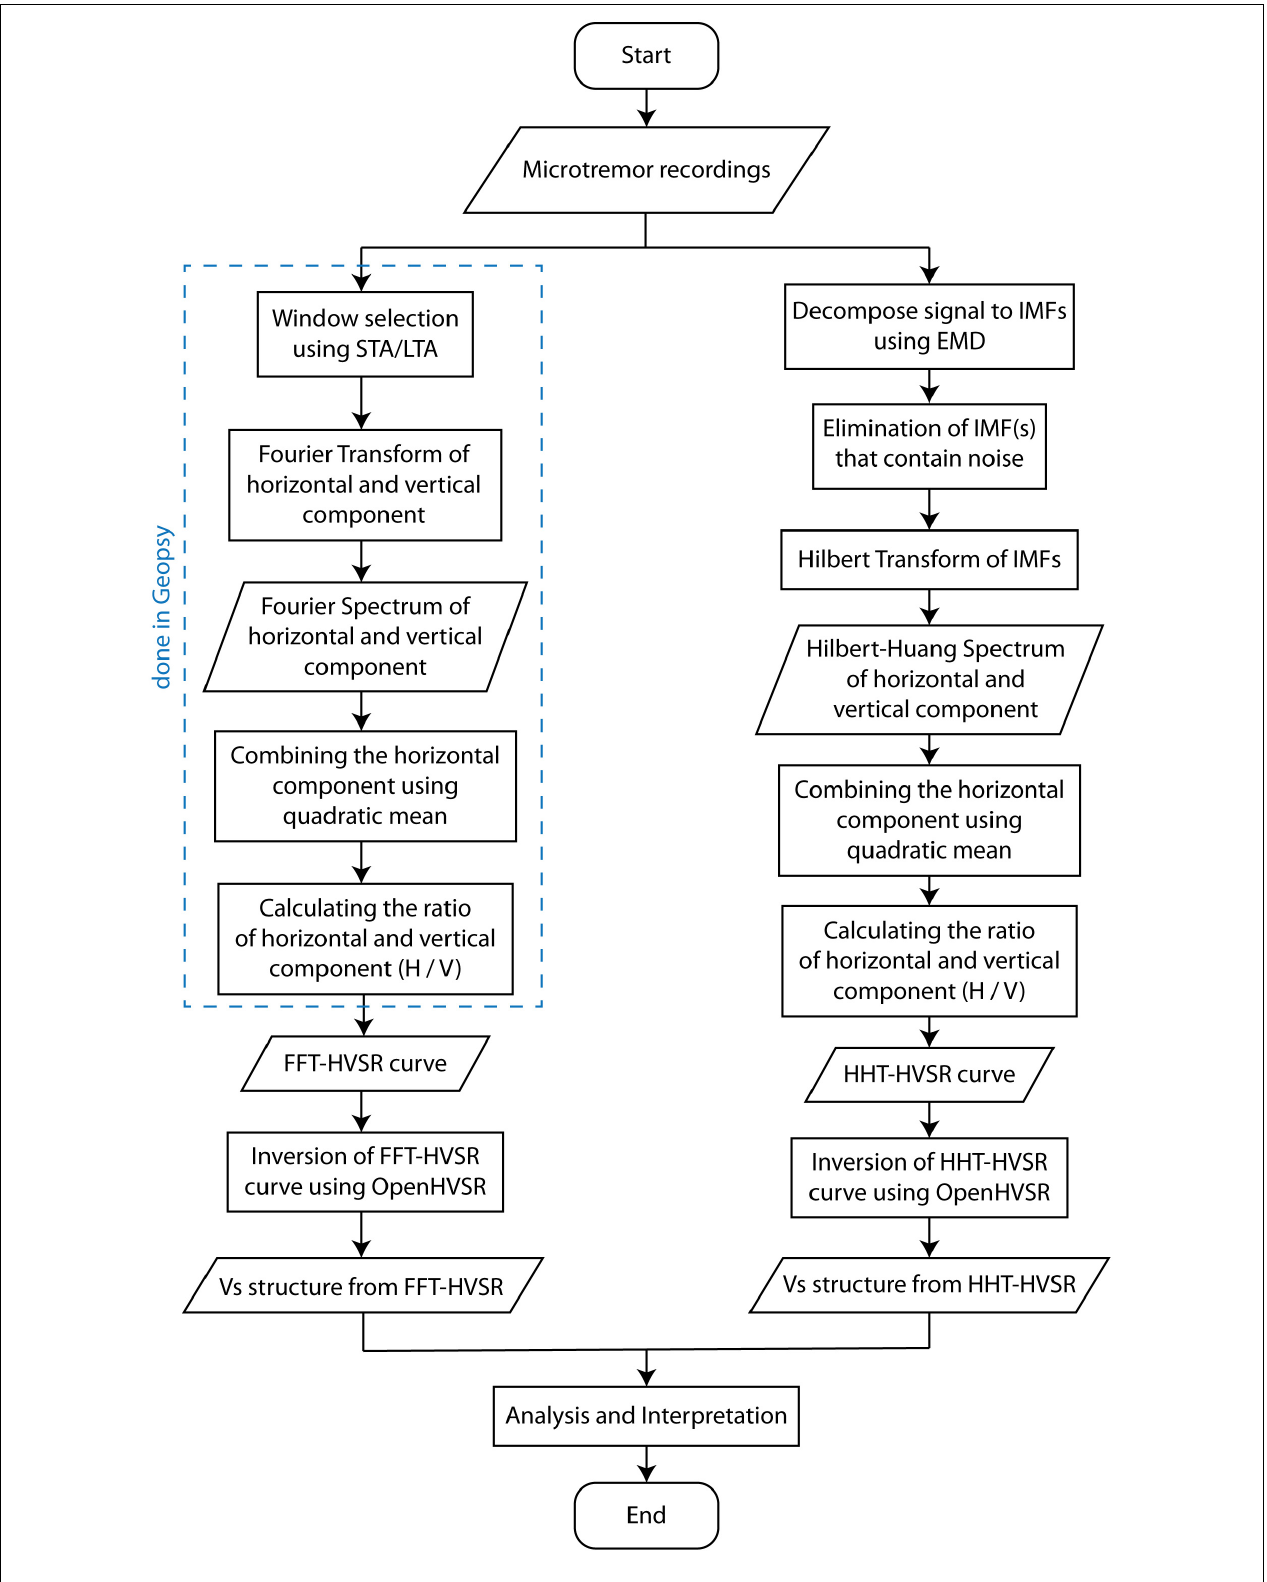
FIGURE 5 | Flowchart of the processes done in this study.